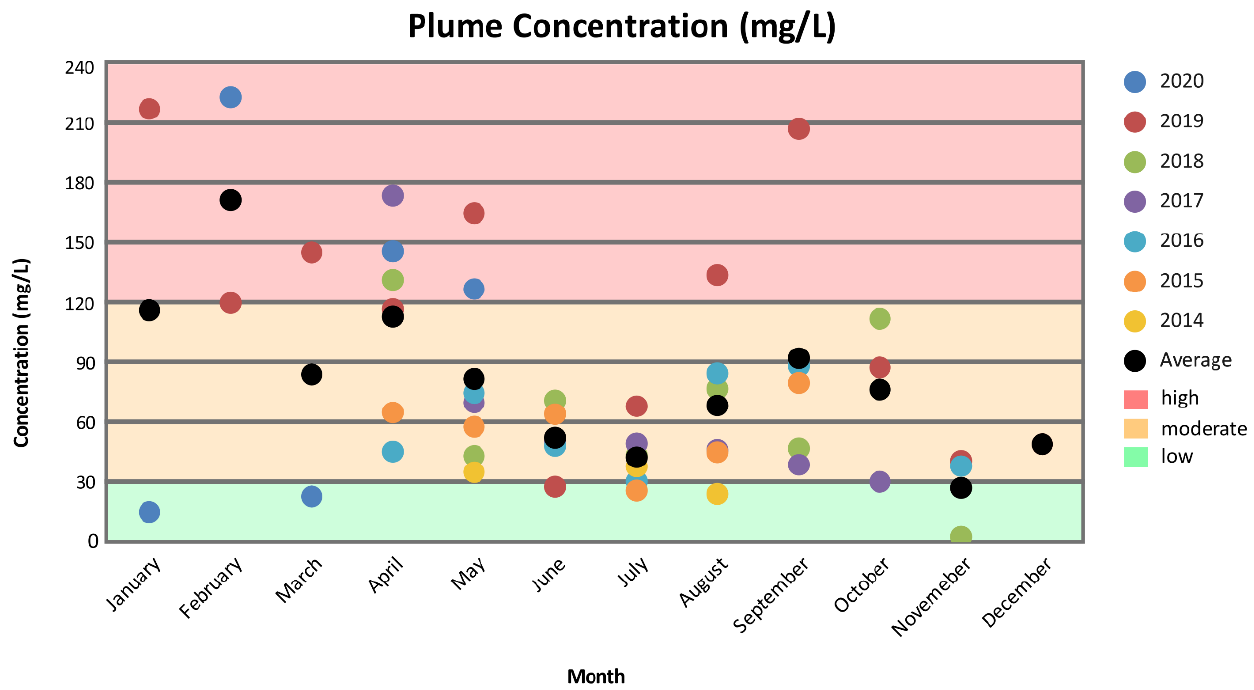
Figure 4. Suspended sediment concentration in the Peace River plume (mg/L) by month from 2014 to 2020 obtained via satellite imagery analysis. Plume activity is indicated by colour shading (see text for explanation).